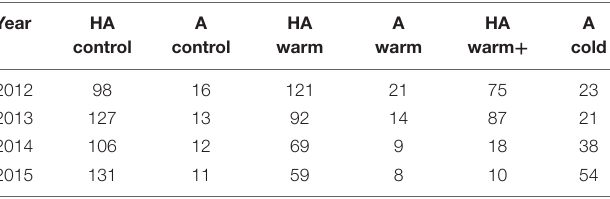
TABLE 1 | Population sizes in all transplant treatments and sites in the four study